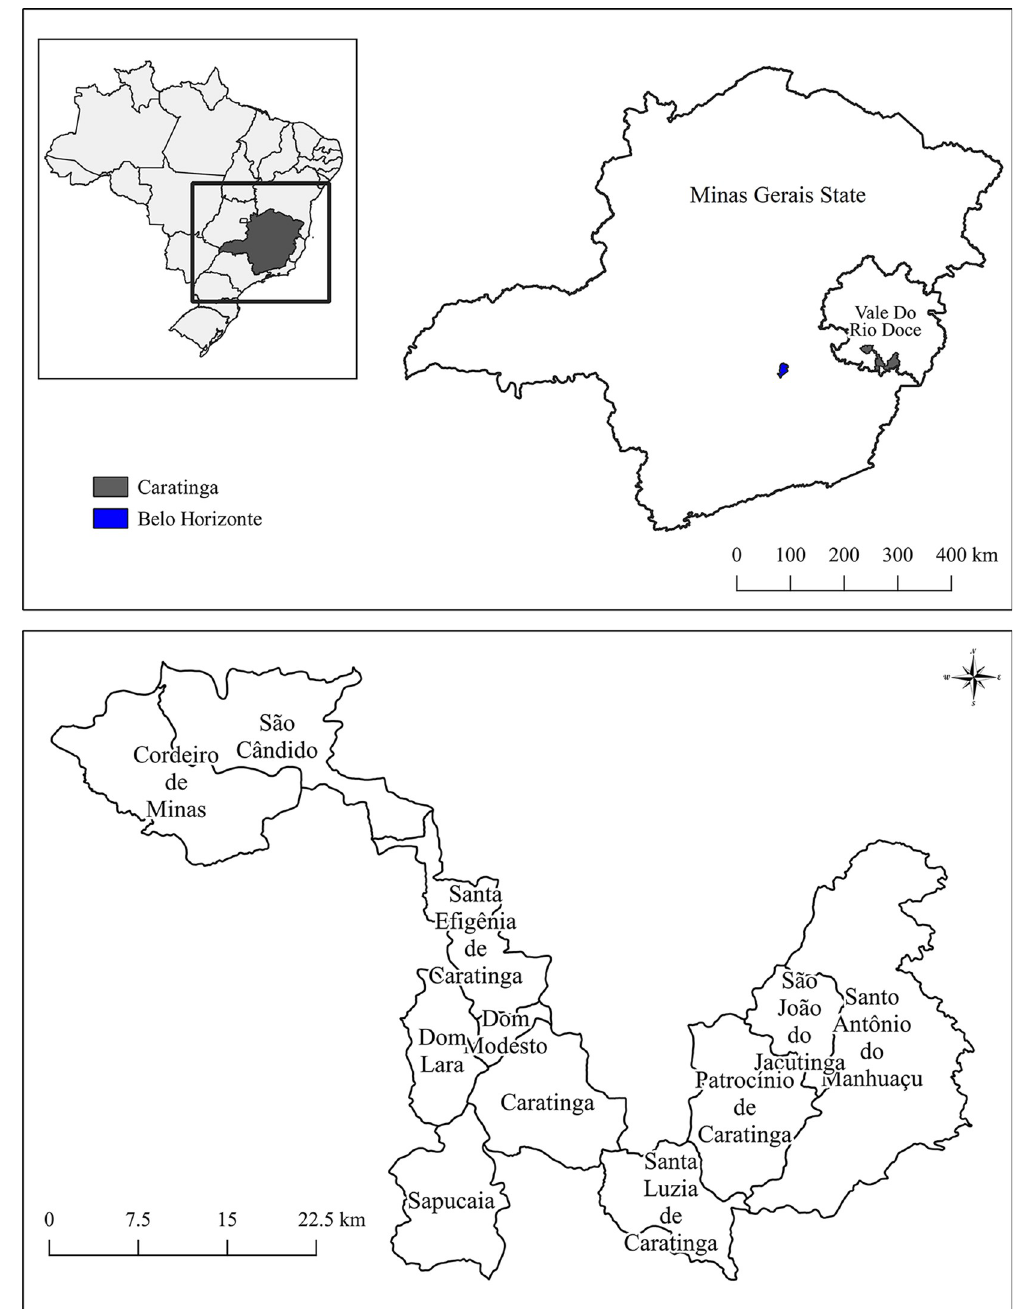
Fig 1. Location of the municipality of Caratinga and their districts in the state of Minas Gerais, Brazil (www.ibge.gov.br).